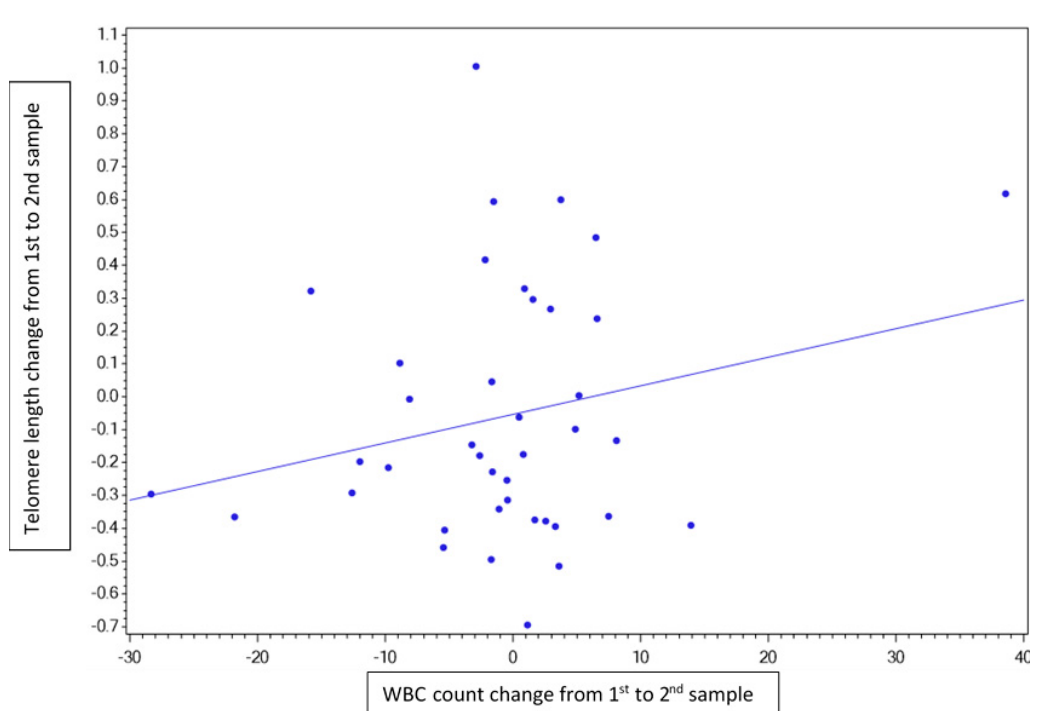
Figure 2. Pearson correlation graph. This figure demonstrates a weak link between telomere dynamics (di ff erence in length between first and second measurement) and white blood cells (WBC) count dynamics (subtracted from WBC sampling on the day of telomere